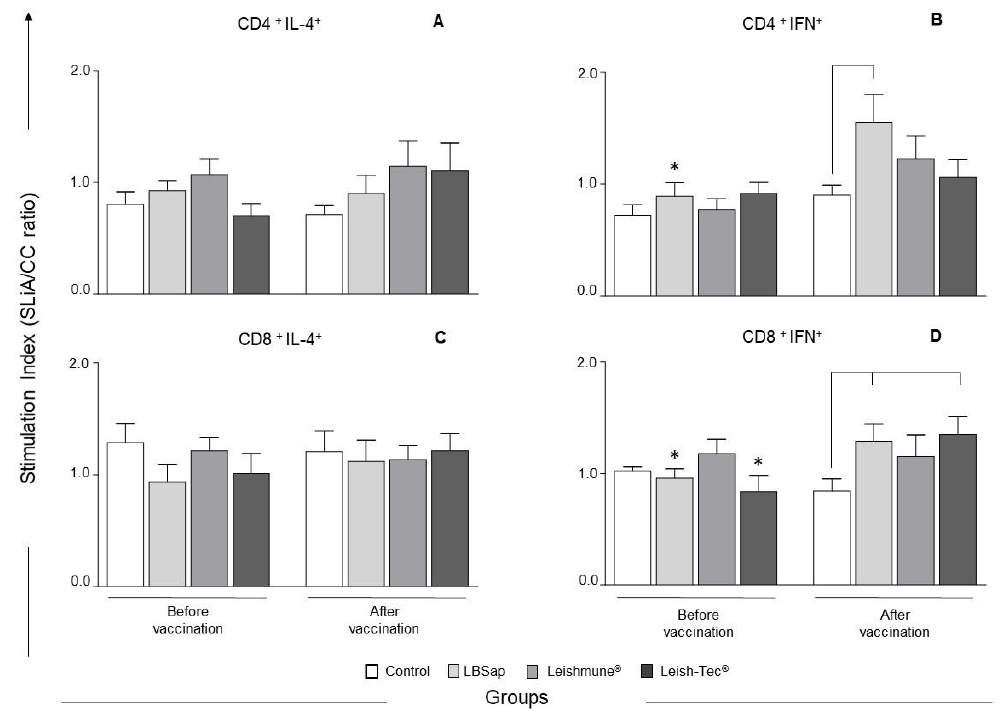
Figure 5. Profile of intracytoplasmatic cytokines in peripheral blood mononuclear cells (PBMCs) after stimulation with soluble L. infantum antigen (SLiA) in dogs submitted to different vaccination protocols: C (control; ); LBSap (killed L. braziliensis vaccine plus saponin; ); Leishmune ® ( ); Leish-Tec ® (